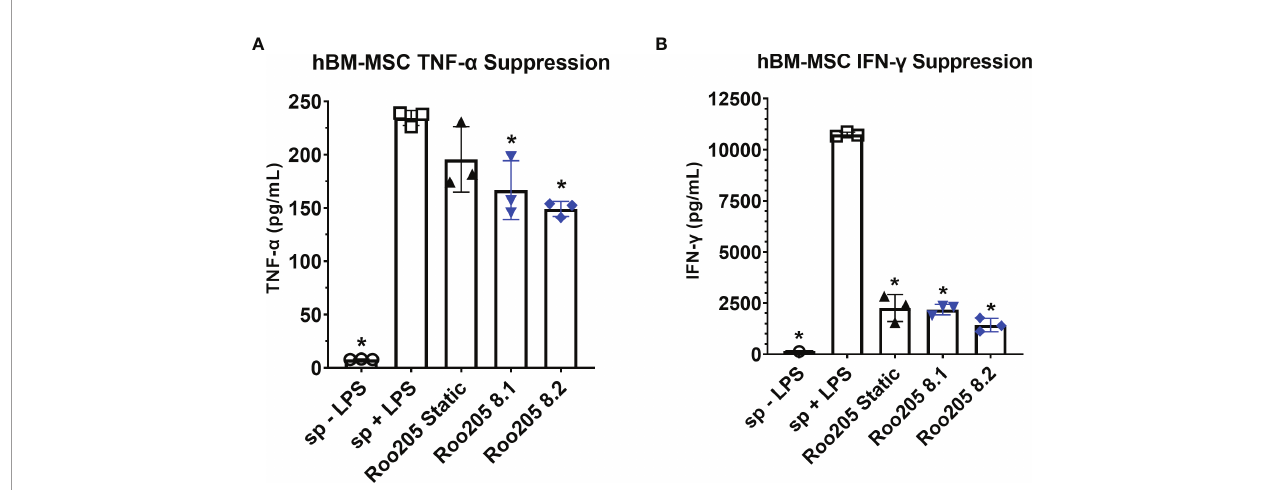
FIGURE 5 | WSS-conditioned hBM-MSC suppress activated splenocyte cytokine production. (A) The TNF- a concentration produced by LPS-activated splenocyte in co-culture with MSC at a ratio of 1 MSC: 20 splenocytes, after 24 hrs incubation determined using a rat-speci fi c ELISA (n=3 independent experiments; one-way ANOVA with Tukey ’ s multiple comparison test, *p<0.05, LPS-activated splenocytes versus other groups). Data represent Mean ± SD. (B) The IFN- g concentration produced by ConA-activated splenocyte in co-culture with MSC at a ratio of 1:80 MSC to splenocyte, after 48 hrs incubation determined using a rat speci fi c ELISA (n=3 independent experiments; one-way ANOVA with Tukey ’ s multiple comparison test, *p<0.05, ConA-activated splenocytes versus other groups). Data represent Mean ± SD.